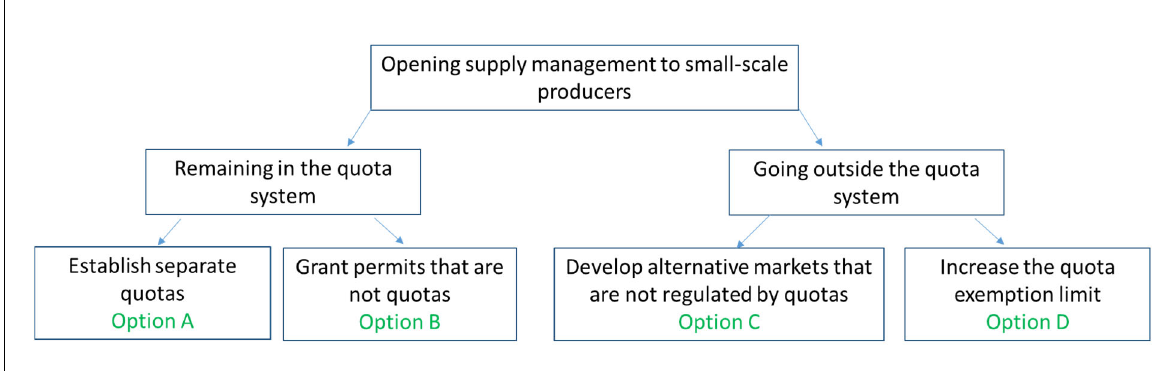
Figure 2. Supply Management Reform